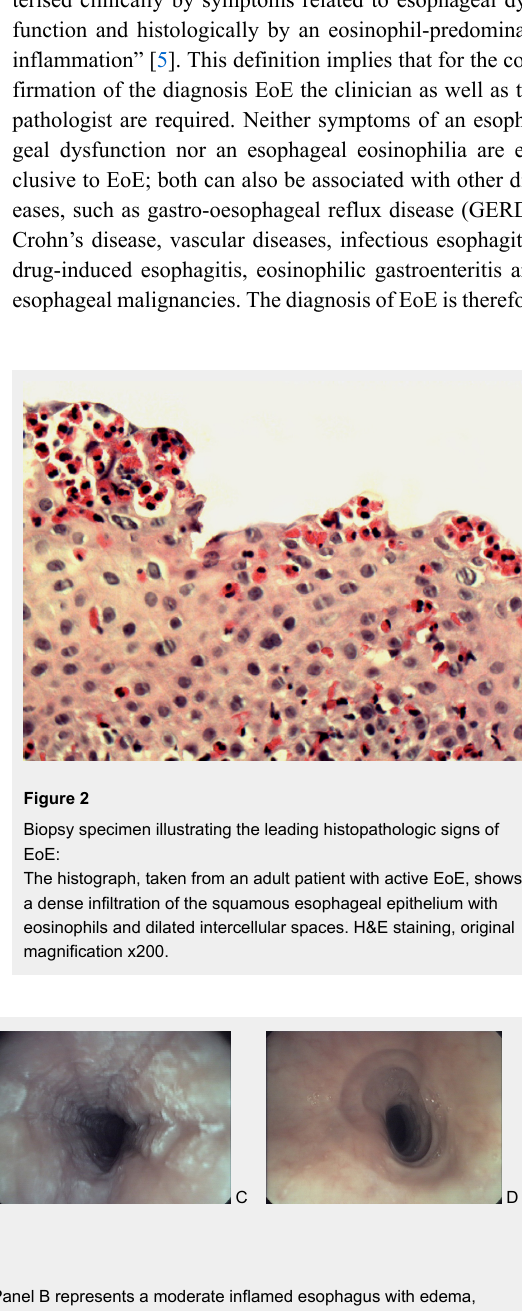
Endoscopic pictures illustrating the major endoscopic signs of EoE: Panel A illustrates the endoscopic appearance of a healthy esophagus. Panel B represents a moderate inflamed esophagus with edema, longitudinal furrowing and mild non-stenosing trachealisation. Panel C shows a severe inflamed esophagus with edema, white exudates and deep furrowing. Panel D illustrate signs associated with remodeling such as stricture due to fixed esophageal